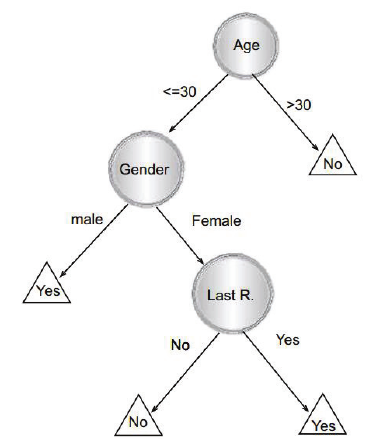
Fig. 4. Decision Tree on Responses to Direct Mailing (Oded, and Lior. 2010)